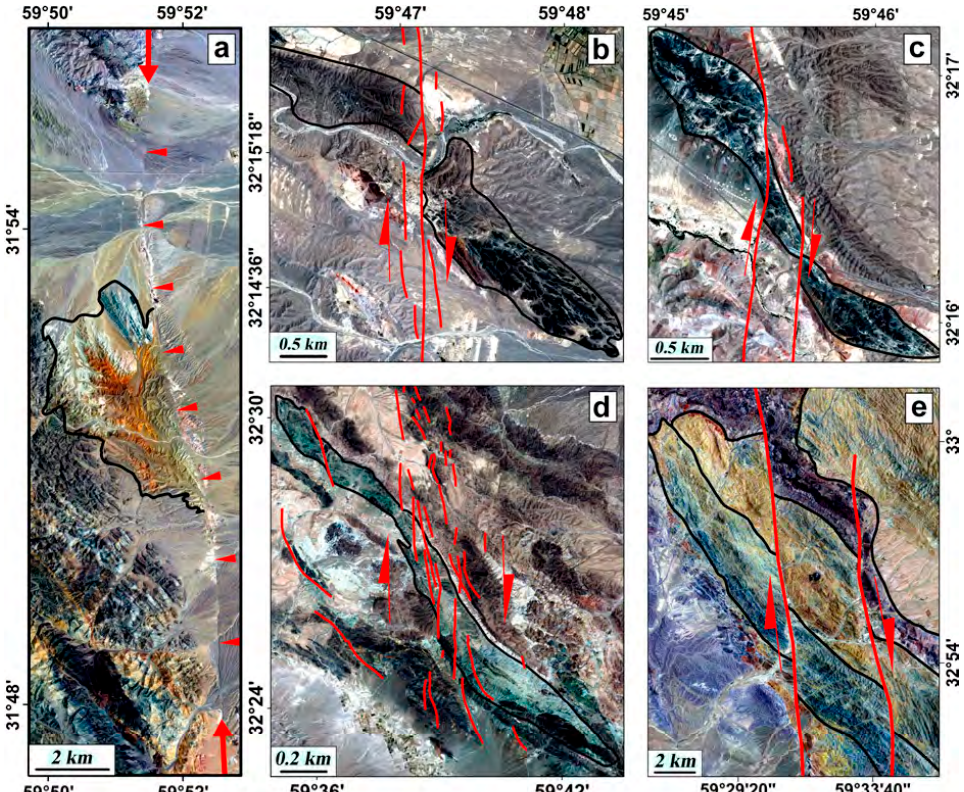
Figure 2. The Bing maps aerial imagery of the N-S right-lateral strike-slip faults in the study area. ( a ) The Esmaeilabad fault trace with a restraining left-bend marked by small arrows; ( b , c ) ~1.5 km right-lateral dragging and offsets of the Cretaceous peridotites along the Esmaeilabad fault; ( d ) ~800 m right-lateral dragging of the upper Cretaceous peridotites along the southern segment of the Pokht fault; ( e ) ~2 km right-lateral offsets of the Paleocene-Pliocene rock units along the Kuch fault. The long arrows show the relative shear movement across the